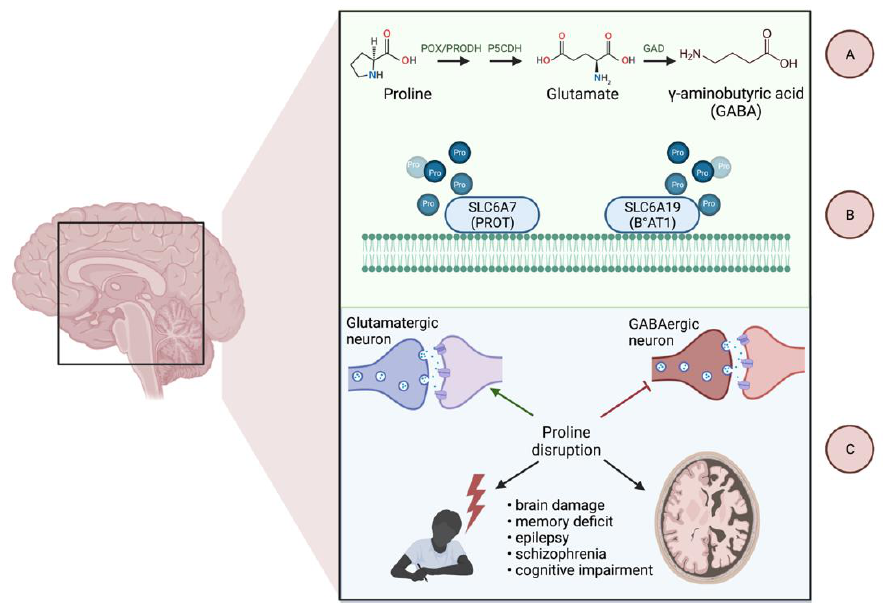
Figure 2. The role of proline in brain function. ( A ) Proline is a forerunner of key CNS neurotrans- mitters, glutamate, and GABA. ( B ) Therefore, proline concentration in the synaptic cleft is precisely controlled by dedicated transporters. ( C ) Disturbances in proline metabolism affect both the develop- ing and the adult brain, causing neurotoxic effects. GAD—glutamate decarboxylase. Created with BioRender.com, accessed on 2 February 2022.